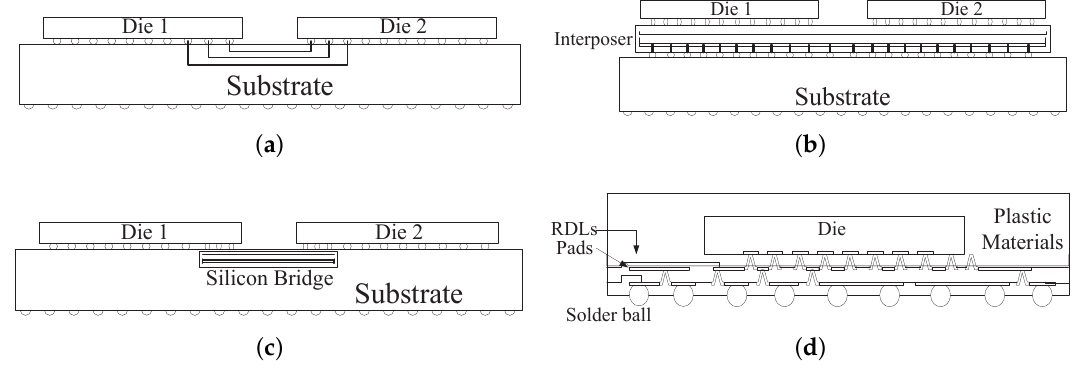
Figure 3. Description of Chiplet Packaging Technologies; ( a ) Substrate-based Packaging, ( b ) Silicon Interposer-based Packaging, ( c ) Silicon Bridge-based Packaging, ( d ) RDL-based